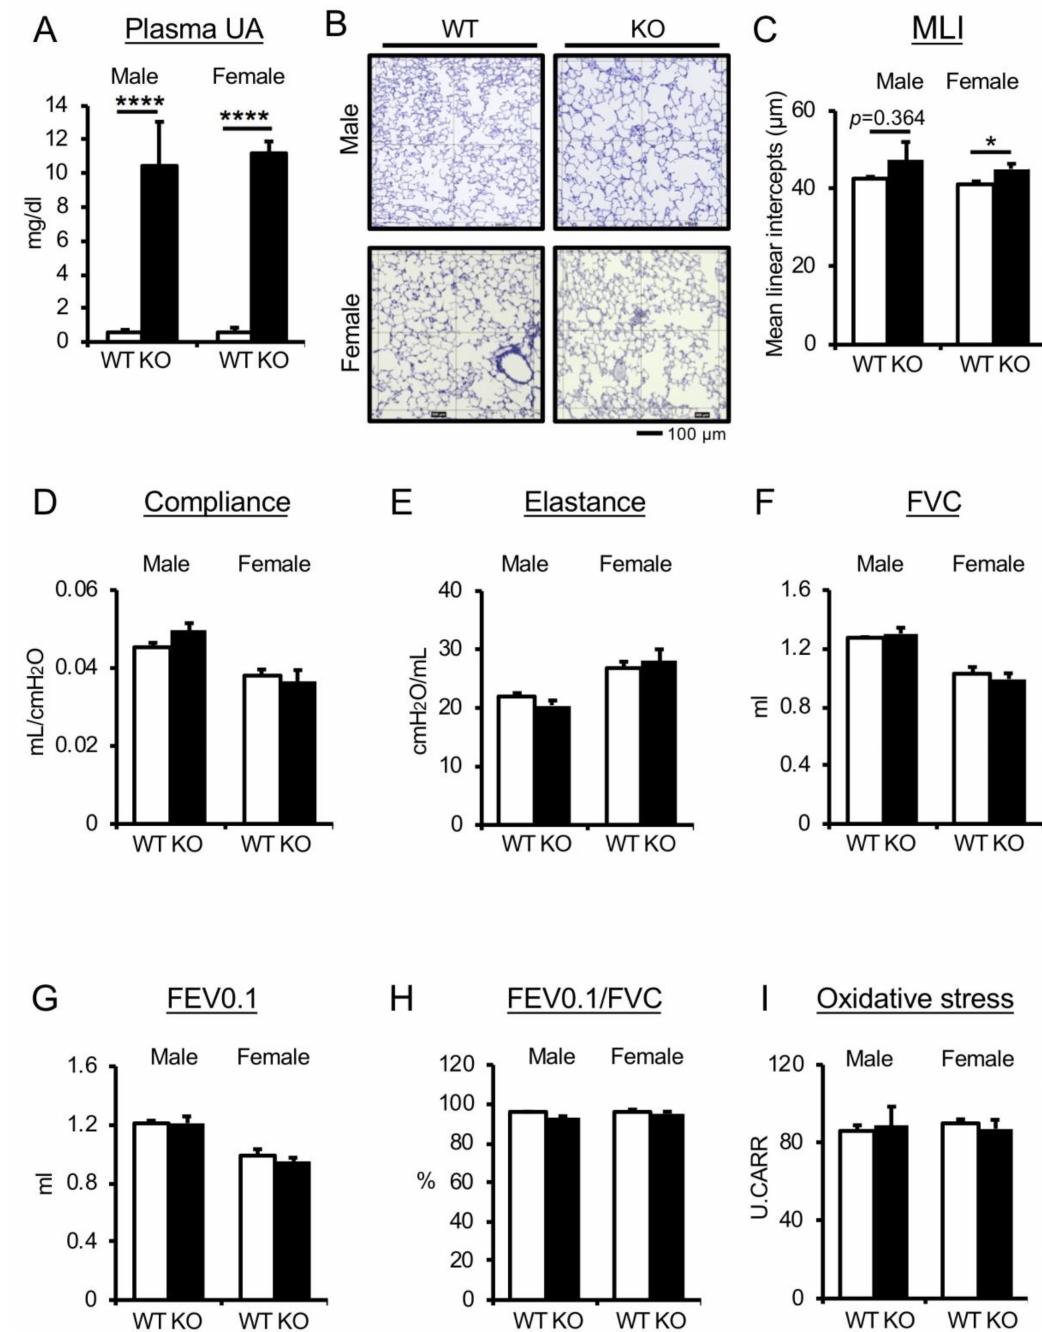
Figure 1. Genetic depletion of uricase does not a ff ect pulmonary phenotype in nondiseased C57 / BL6J mice. ( A ) Plasma uric acid (UA) levels (mg / d) in male and female wild type (WT) and Uox-knockout (KO) mice. n = 3–4 mice / group. **** p < 0.0001, versus WT; Student’s t -test. ( B,C ) Emphysematous phenotypes in male and female WT and Uox-KO mice. ( B ) Periodic acid-Schi ff (PAS)-stained lung sections. Square diameter = 300 µ m. Scale bar = 100 µ m. ( C ) Quantitative morphometric analysis of alveolar septa (mean linear intercept (MLI)). n = 4–6 mice / group. * p < 0.05, versus WT; Student’s t -test. ( D–H ) Parameters of pulmonary functions are indicated (compliance, elastance, forced vital capacity (FVC), forced expiratory volume in 0.1 seconds (FEV0.1), FEV0.1 / FVC). n = 4–6 mice / group. Compared with WT; Student’s t test. ( I ) Plasma oxidative stress levels in male and female WT and Uox-KO mice. n = 3–6 mice / group. Compared with WT; Student’s t -test. Data expressed as mean ±